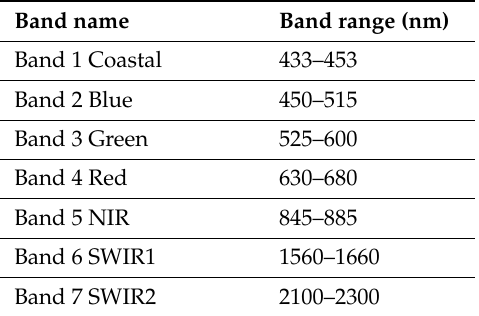
Table 2. Spectral ranges of Landsat 8 image